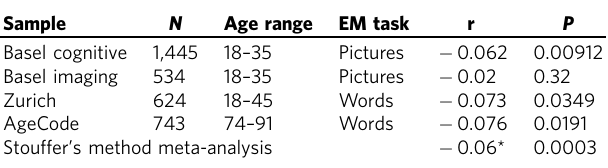
Table 2 | Association of Haemopoetic or Lymphoid Organ development genetic score and EM-related traits in independent